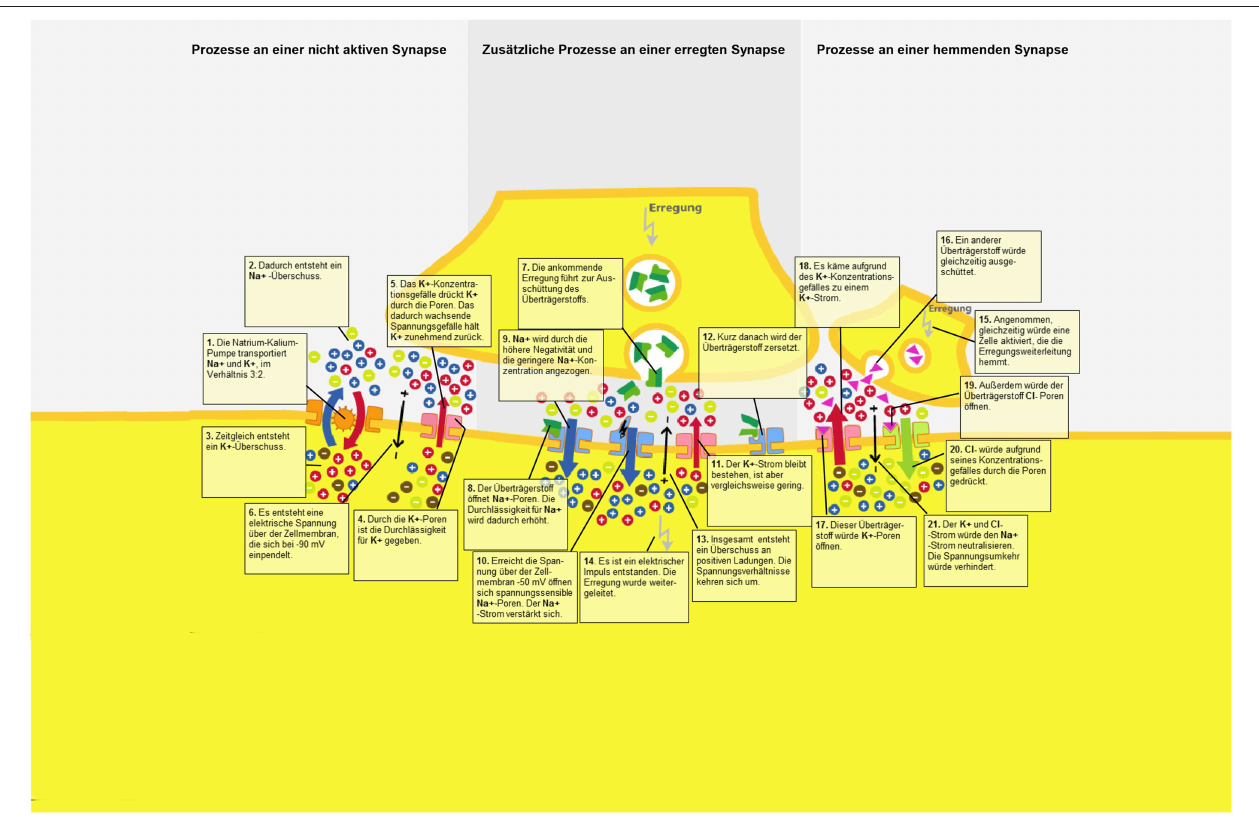
FIGURE 3 | Integrated text-picture presentation with high spatial proximity in Experiment